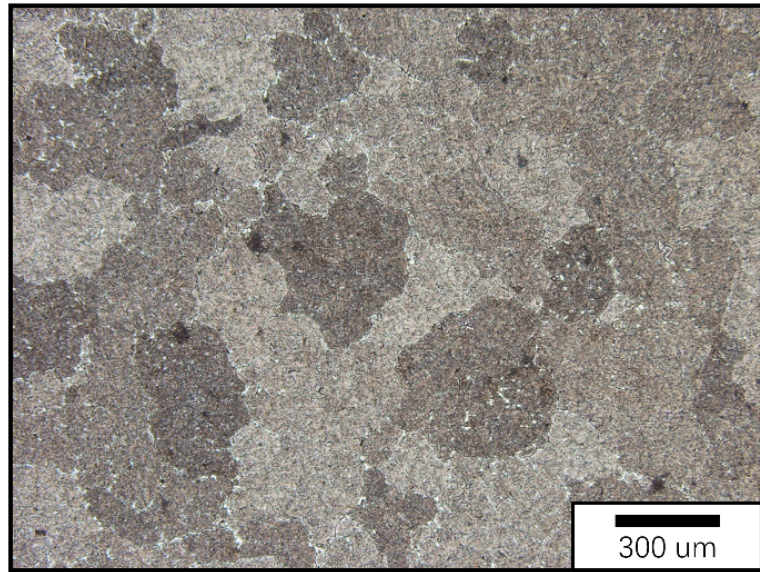
Figure 5. Initial grain morphology.